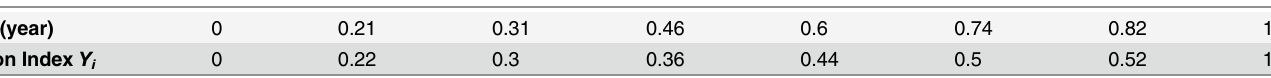
Table 3. Average Attrition Index of lower molar after